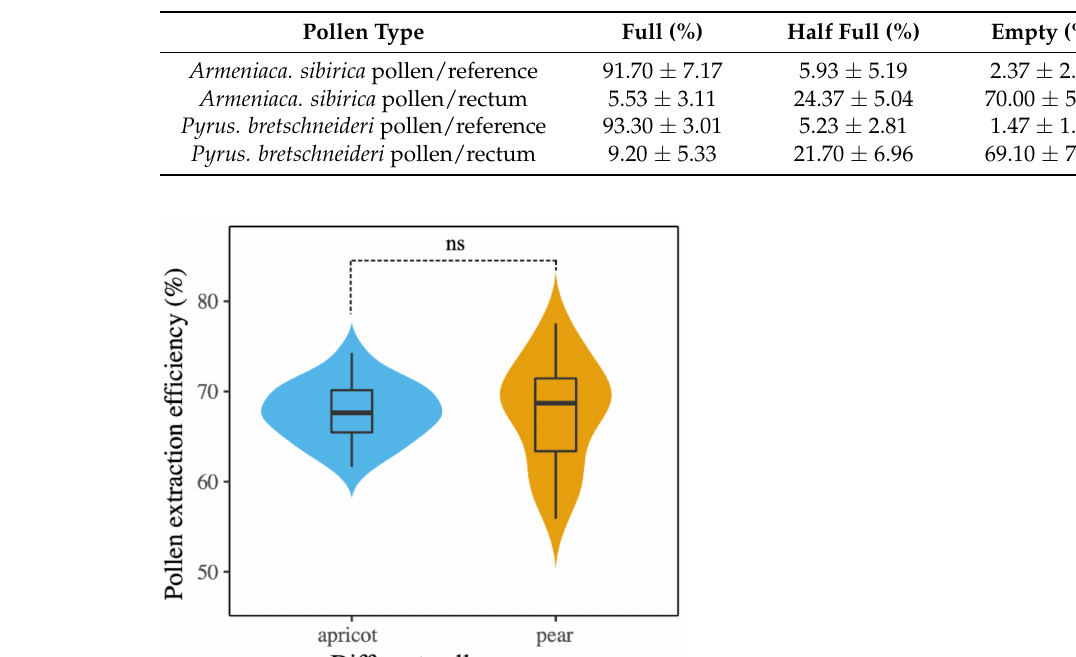
Table 1. Percentages of full, half-full, and empty pollen grains in the reference pollen (before digestion) and the rectal contents of dissected workers (after digestion).